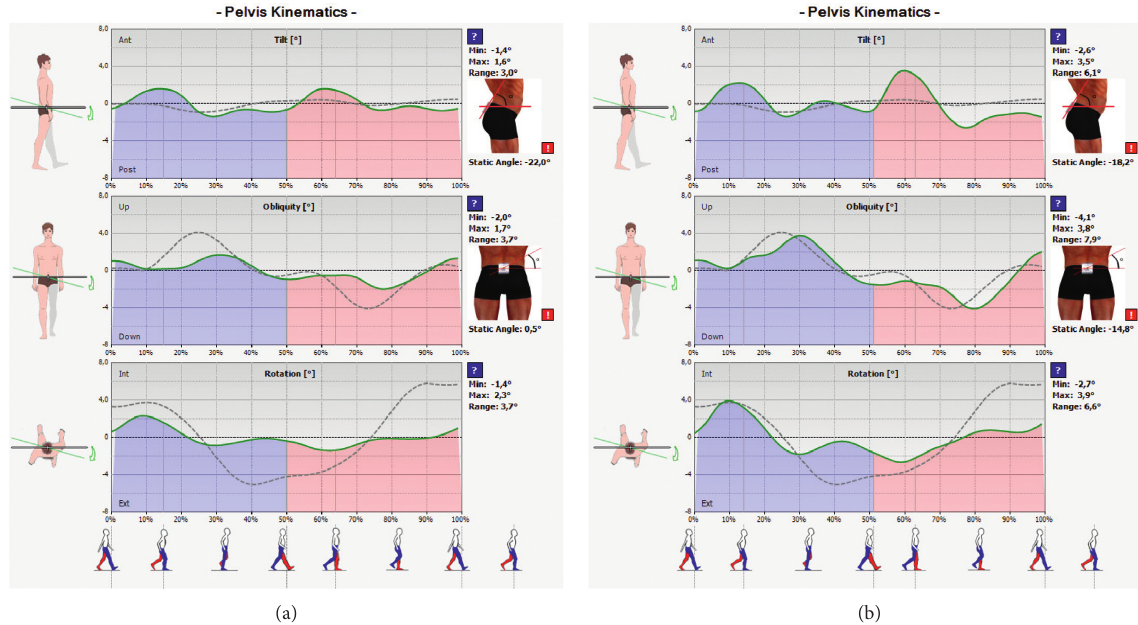
Figure 4: The exemplary result of pelvic parameters during standing and pelvic kinematics. The examination was performed at a therapeutic session: the result (a) before a therapeutic session and (b) after a therapeutic session.